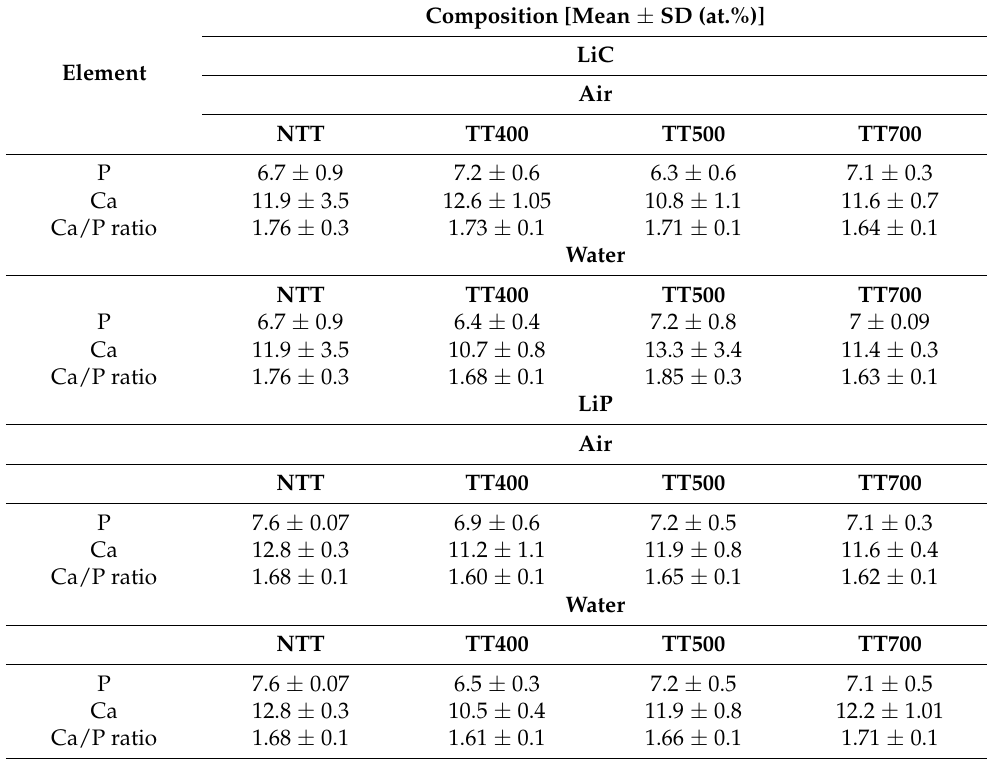
Table 2. Ca/P atomic ratio corresponding to NTT LiC and LiP coatings, and of those subjected to post-deposition thermal treatments (at different temperatures), in air and water-vapor ambient. Composition [Mean ± SD (at.%)] LiC Element NTT TT400